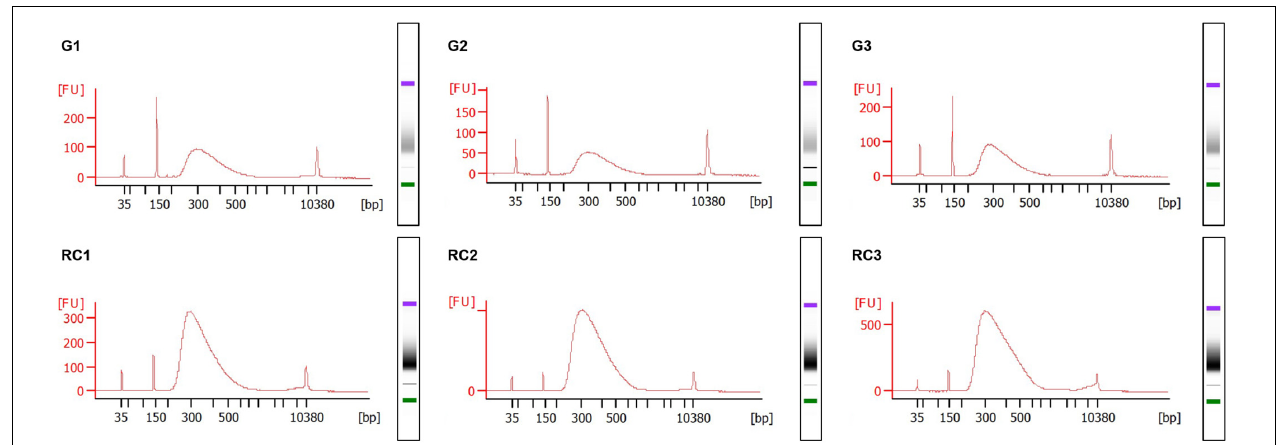
FIGURE 5 | Electropherograms of RNA sequencing (RNA-seq) libraries. TruSeq Stranded mRNA Library Prep Kit from Illumina R (cid:13) was used to prepare the libraries of the 3 days post infection (dpi) samples, strictly following the manufacturer’s instructions. The fragment size distribution of the libraries were checked in the Agilent R (cid:13) 2100 Bioanalyzer using the Agilent R (cid:13) High Sensitivity DNA Kit (Agilent Technologies, Inc., Santa Clara, CA, United States). Gall samples: G1 to G3; Control roots samples: RC1 to RC3. Standard size ladder in nucleotides (bp) is shown at the X -axis at the bottom of each graph. FU, fluorescent units at the Y -axis. A clear major peak of 300 bp size fragments is observed. The libraries and electropherograms were performed by an external sequencing company (AllGenetics & Biology SL, A Coruña, Spain).